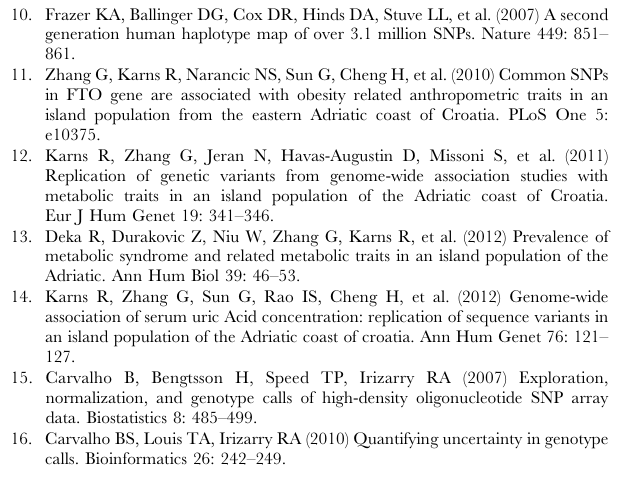
Table S3 The 60 significant loci with secondary signals (ordered by p-value of the secondary